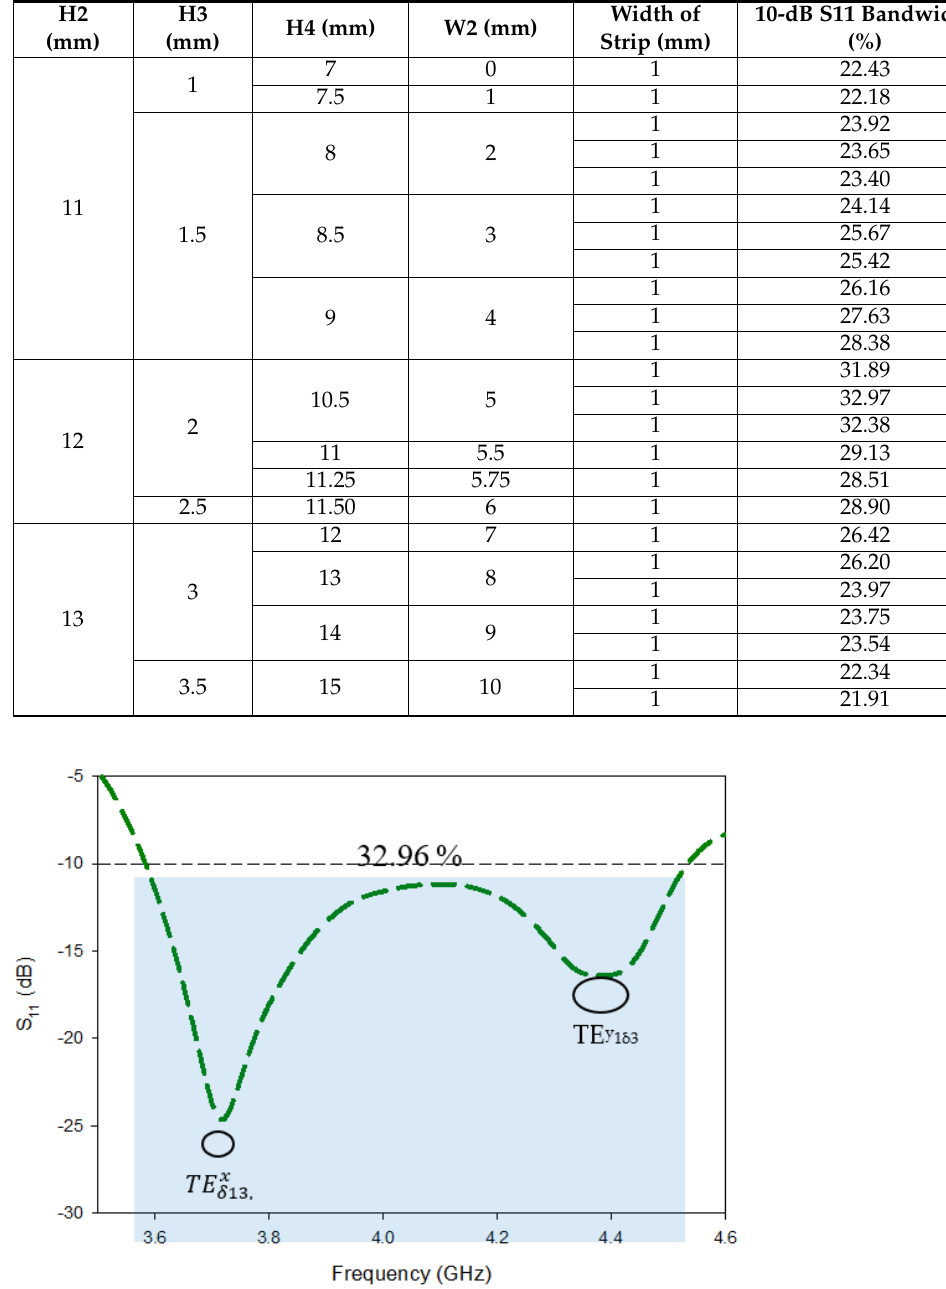
Figure 6. Impedance-matching bandwidth of